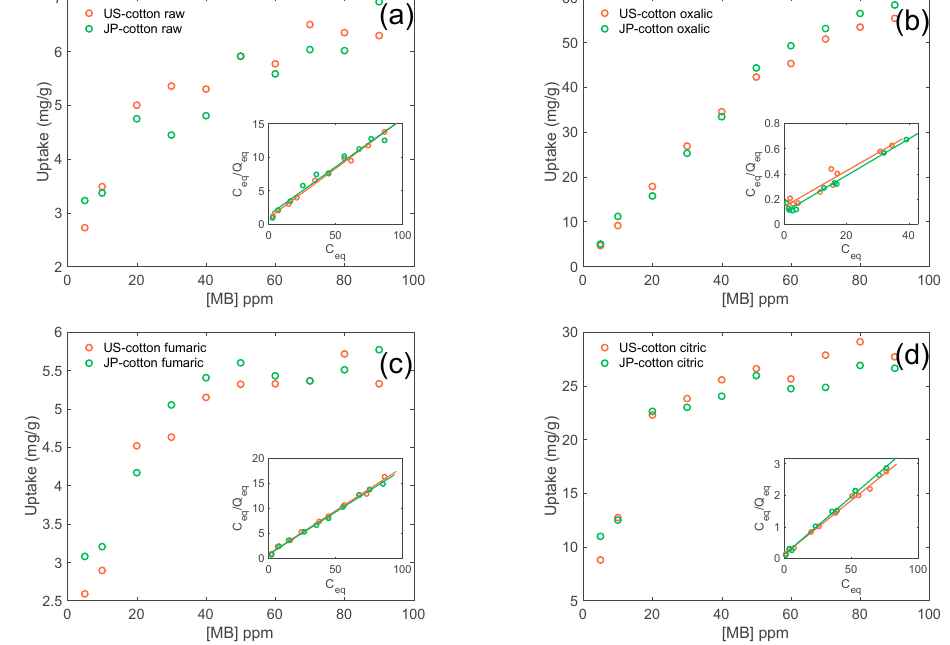
Figure 3. Methylene blue isotherms of ( a ) untreated cotton, ( b ) oxalic acid-treated cotton, ( c ) fumaric acid-treated cotton, and ( d ) citric acid treated cotton. Inset shows the Langmuir linearization of the isotherm.